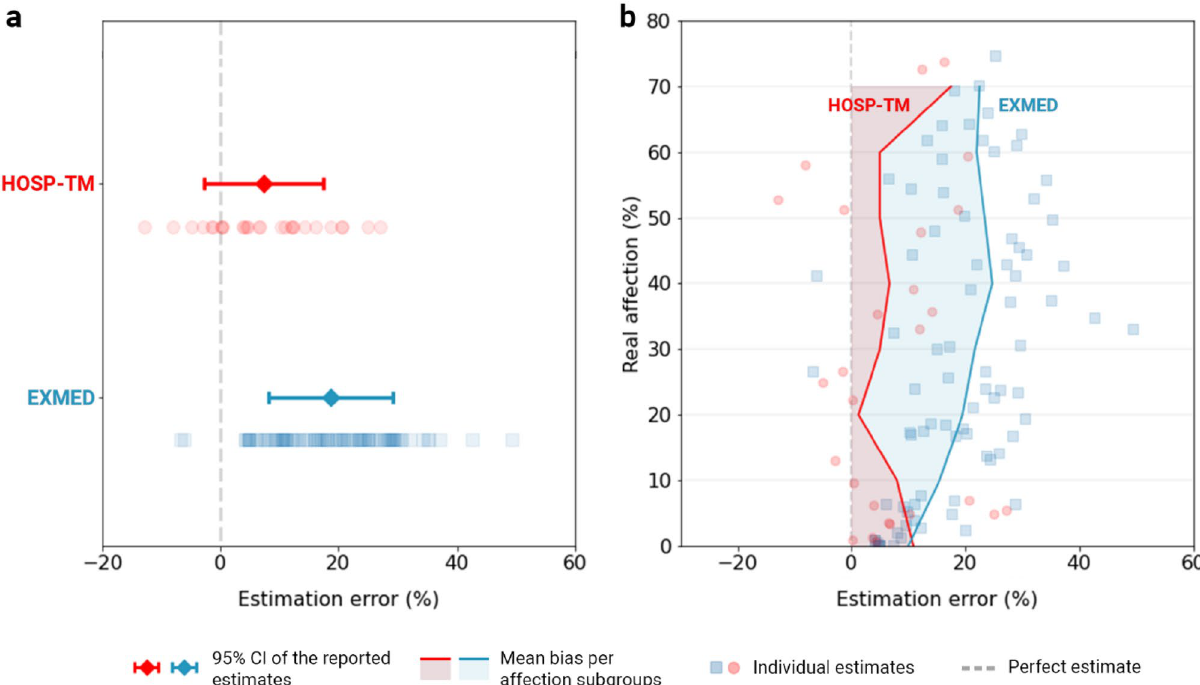
Figure 4. Retrospective overestimation analysis. ( a ) Mean estimation differences in CT studies from Pius Brinzeu County Emergency Hospital (HOSP-TM) and ExMed Medical Network (EXMED). ( b ) Bias disposition across severity